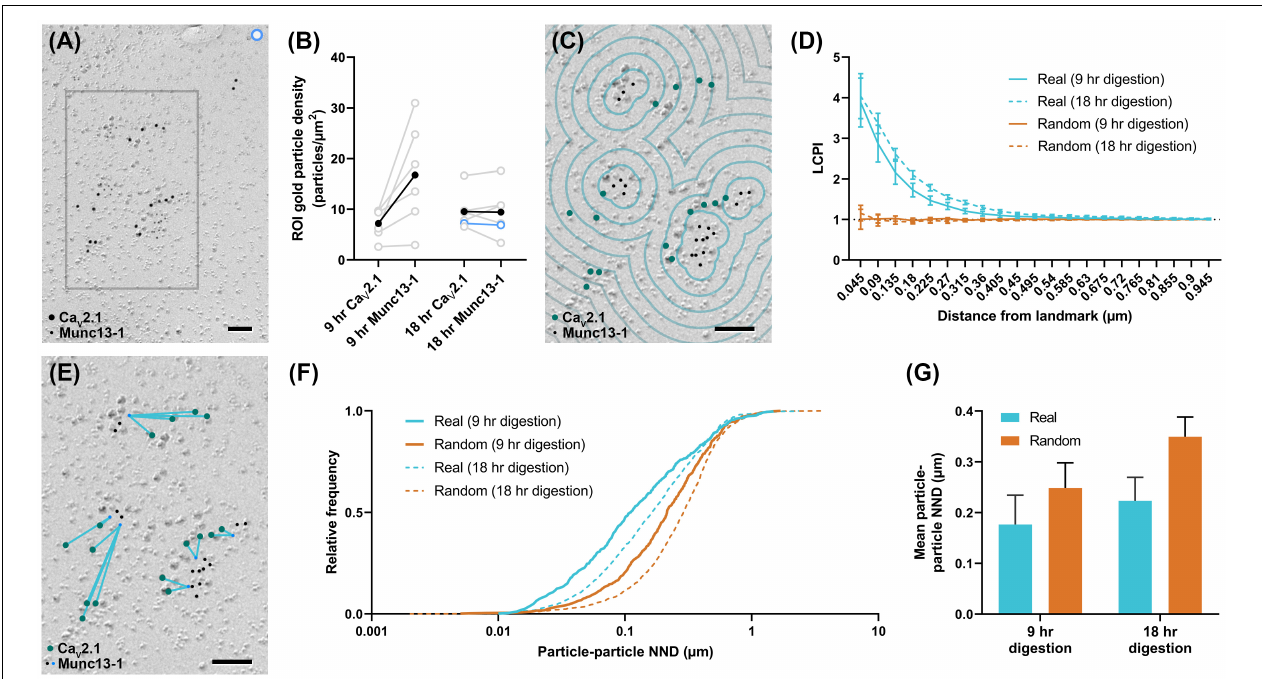
FIGURE 8 | Application of Gold Rippler and Gold Star for synaptic protein analysis. (A) Ca V 2.1 and Munc13-1 colocalize at intramembrane protein-rich regions of the calyx of Held membrane which presumably represent the presynaptic active zone. Only a small portion of the larger membrane face (ROI) is shown. (B) Overall gold particle density across the calyx of Held membrane for two different SDS-digestion conditions. Gray data points represent individual ROIs and gray lines connect Ca V 2.1 and Munc13-1 densities coming from the same ROI. Solid black dots represent mean densities. Ca V 2.1 and Munc13-1 densities from the ROI partially shown in (A) are indicated by light blue circles. (C) Zoomed view of the gray box in (A) showing a conceptual illustration of Gold Rippler for visual clarity. (D) LCPI curve for real and random particle distributions and two SDS-digestion conditions, where Munc13-1 particles are set as landmarks. (E) Zoomed view of the gray box in (A) showing an illustration of Gold Star. When Munc13-1 is set as the landmark, NNDs (blue lines) are measured between each Ca V 2.1 and the closest Munc13-1 particle (blue dots). (F) Cumulative frequency distribution of real and random particle-particle NNDs pooled across the 6 ROIs for each SDS-digestion condition. (G) Grand mean particle-particle NND for each SDS-digestion condition. Error bars represent S.E.M. n = 6 ROIs for each condition. Scale bars: 100